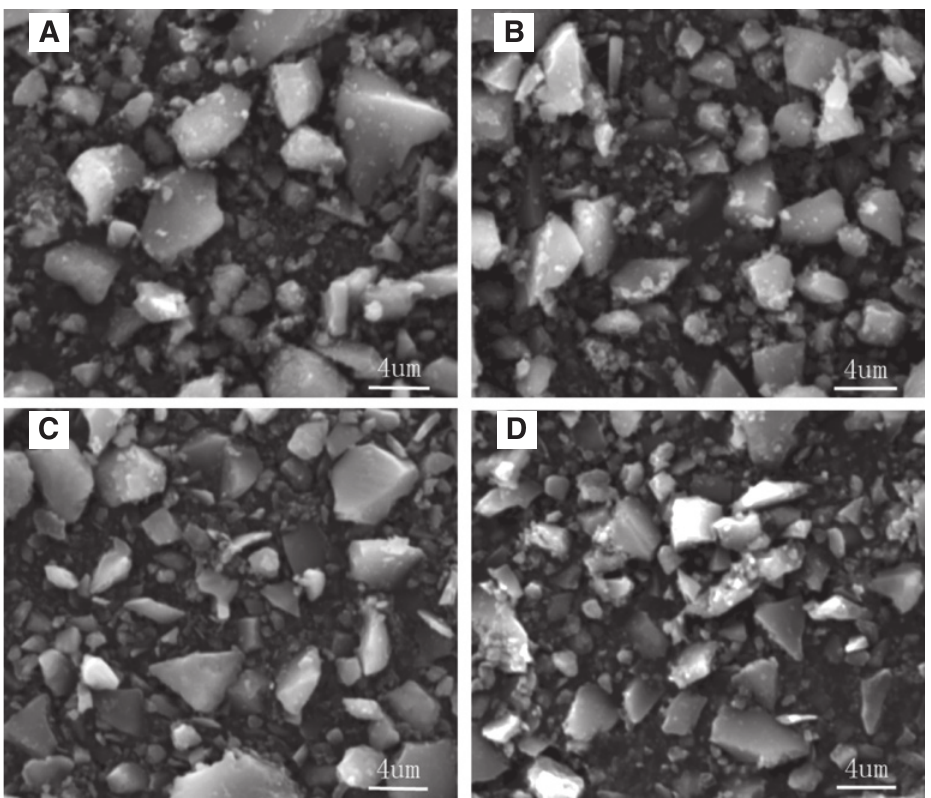
samples with different indium contents. (A) 0.05%Sm-TiO 2 2